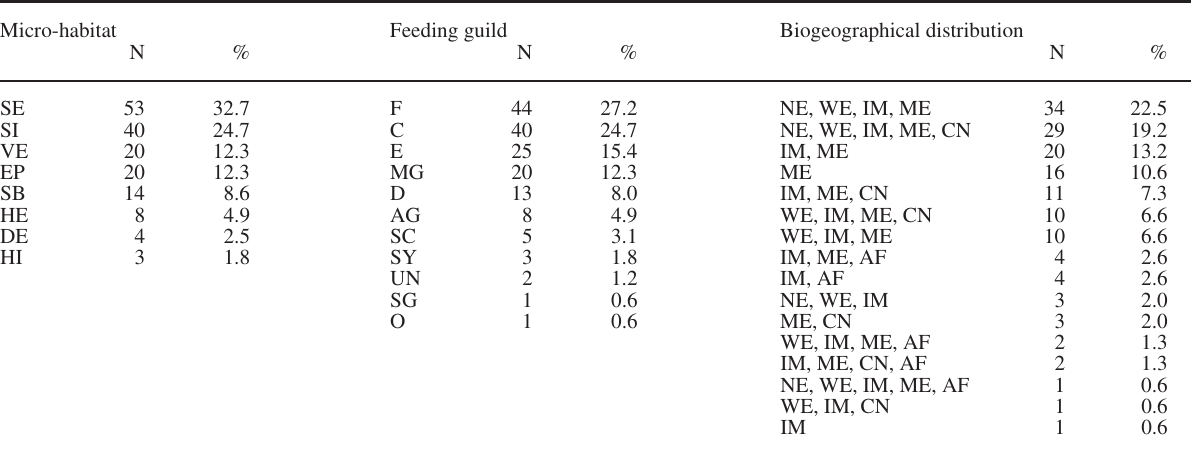
Table 3. – number of species (n) and percentage (%) of each category for preferred micro-habitat, feeding guild and biogeographical distri- bution of the molluscan fauna associated with Zostera marina beds in southern spain. un: unknown. micro-habitat feeding guild Biogeographical distribution